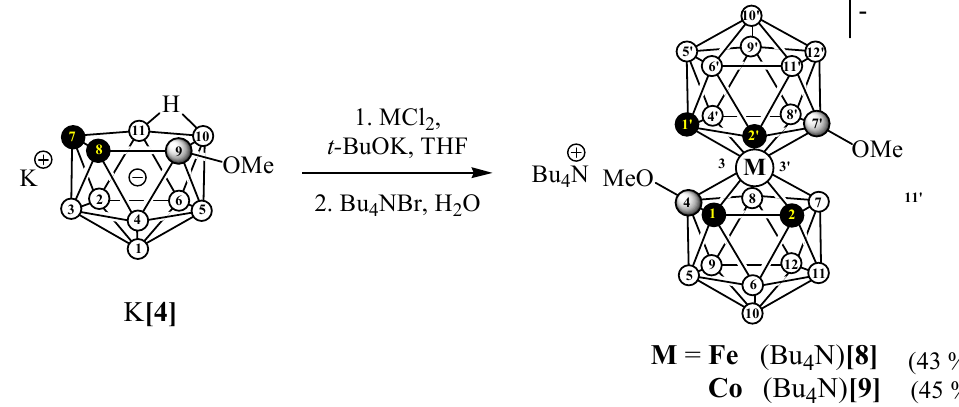
Scheme 5. Synthesis of 4,7 ′ -dimethoxy derivatives of iron and cobalt bis(dicarbollides).